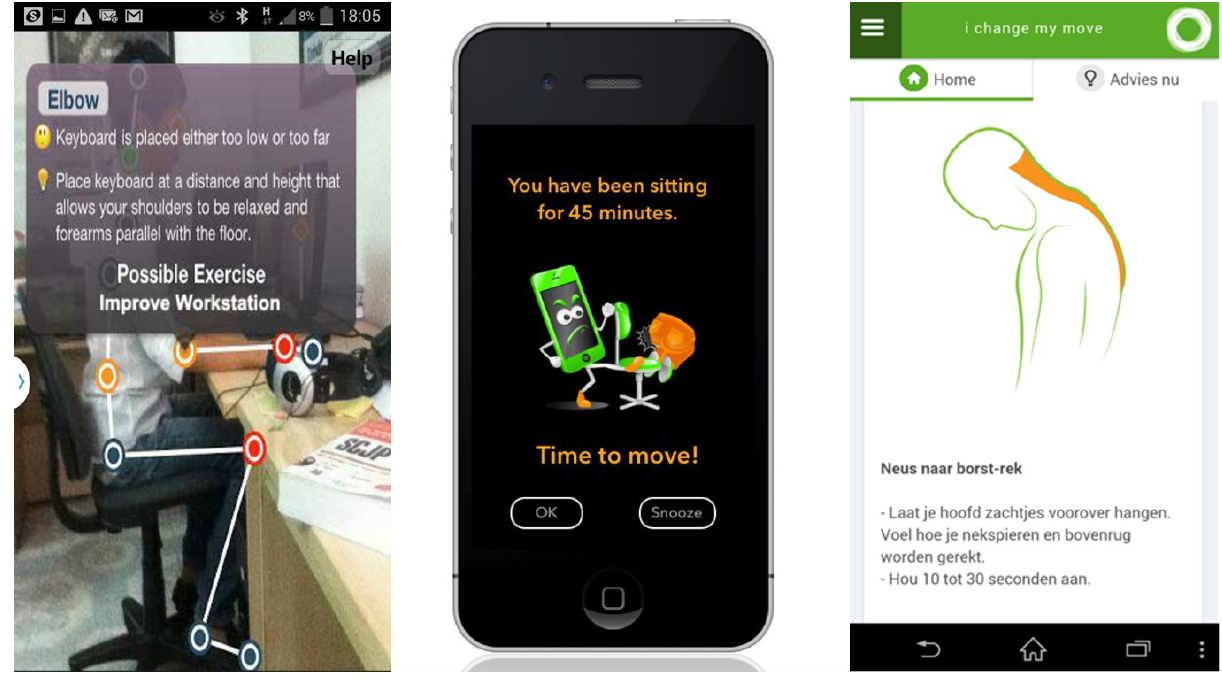
Figure 3. Examples of behavior change techniques used in apps, from left to right: “provide feedback on performance” (Ergo@WSH), “prompt practice” (Get Off Your Butt!) and “model or demonstrate behavior” (iChange2). Pictures have been taken from app descriptions in Google Play store (Ergo@WSH), iTunes (Get Off Your Butt!) and from app provider